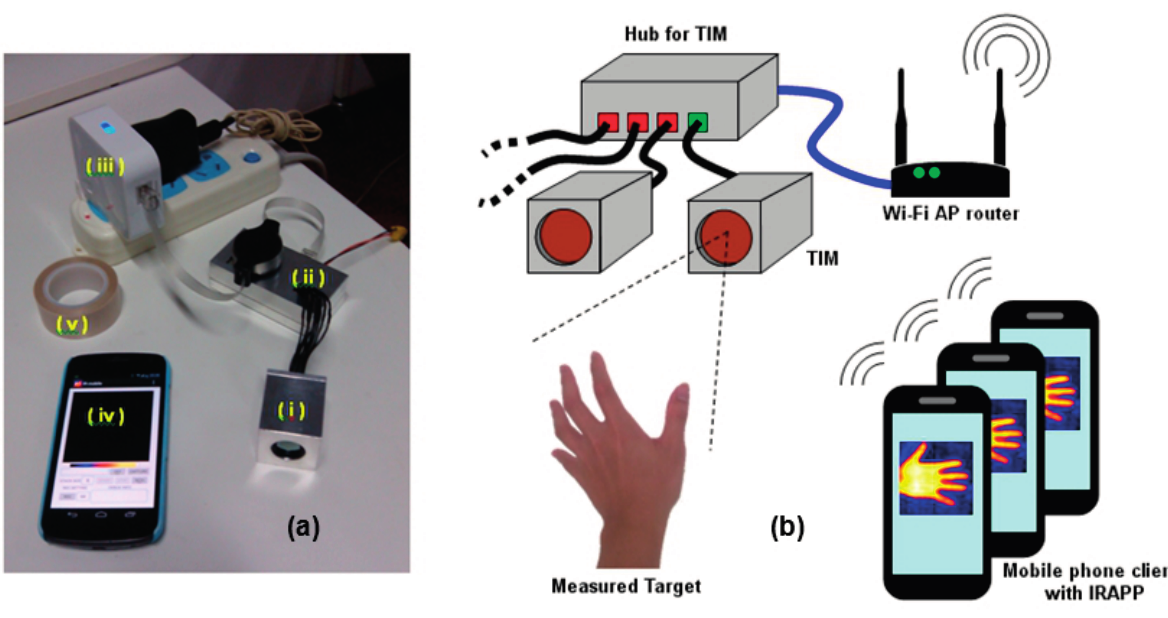
Figure 2. ( a ) The overview of MTIS testing console: (i) TIM; (ii) hub for TIM; (iii) Wi-Fi AP router; (iv) mobile phone client with IRAPP; (v) black body tape for accurate temperature measurement (optional); and ( b ) the architecture of MTIS testing